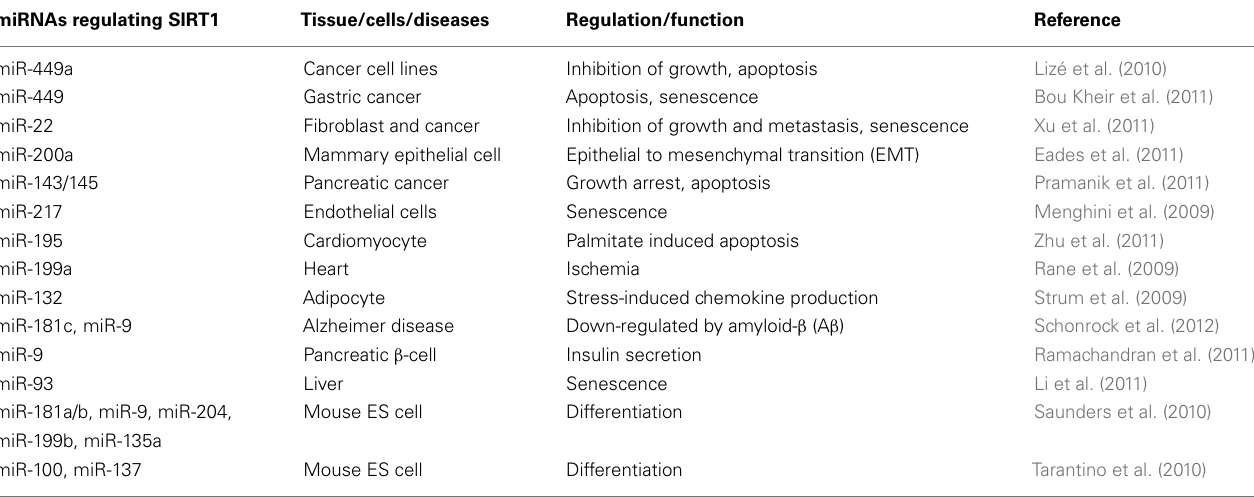
Table 2 |A list of miRNAs targeting